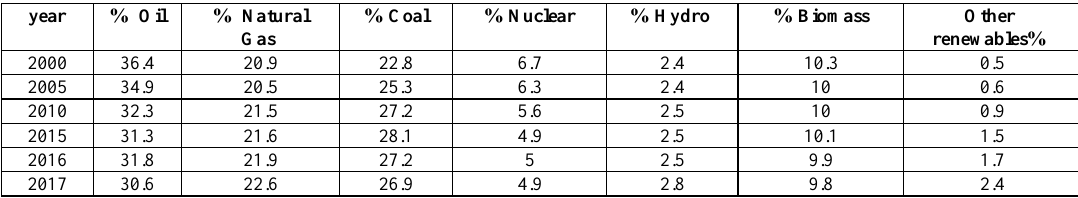
Table 1. The world energy consumption